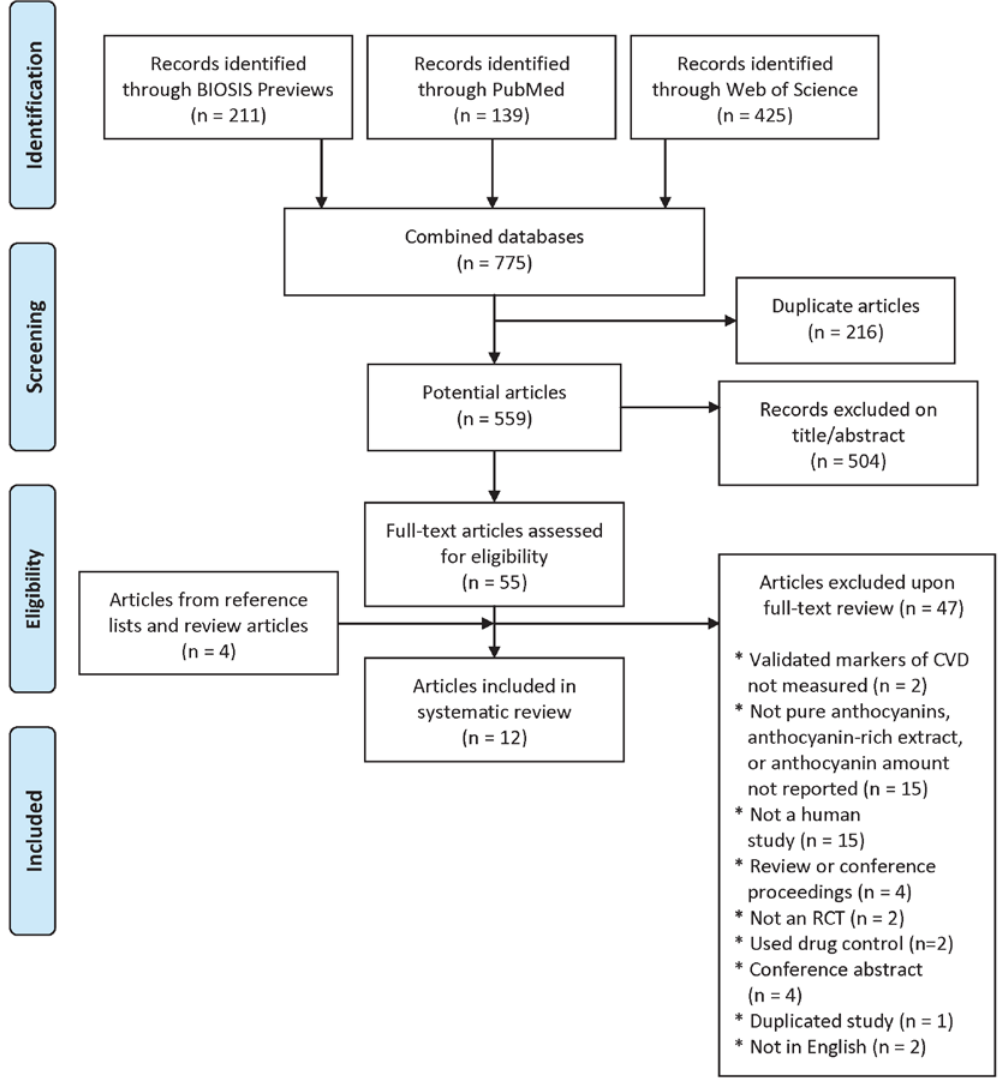
Figure 1. Flow diagram of article selection.